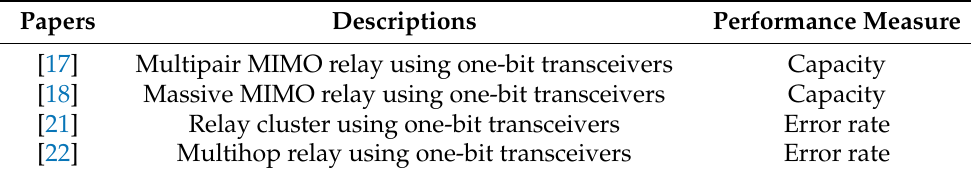
Table 1. Relevant studies for cooperative MIMO systems using one-bit